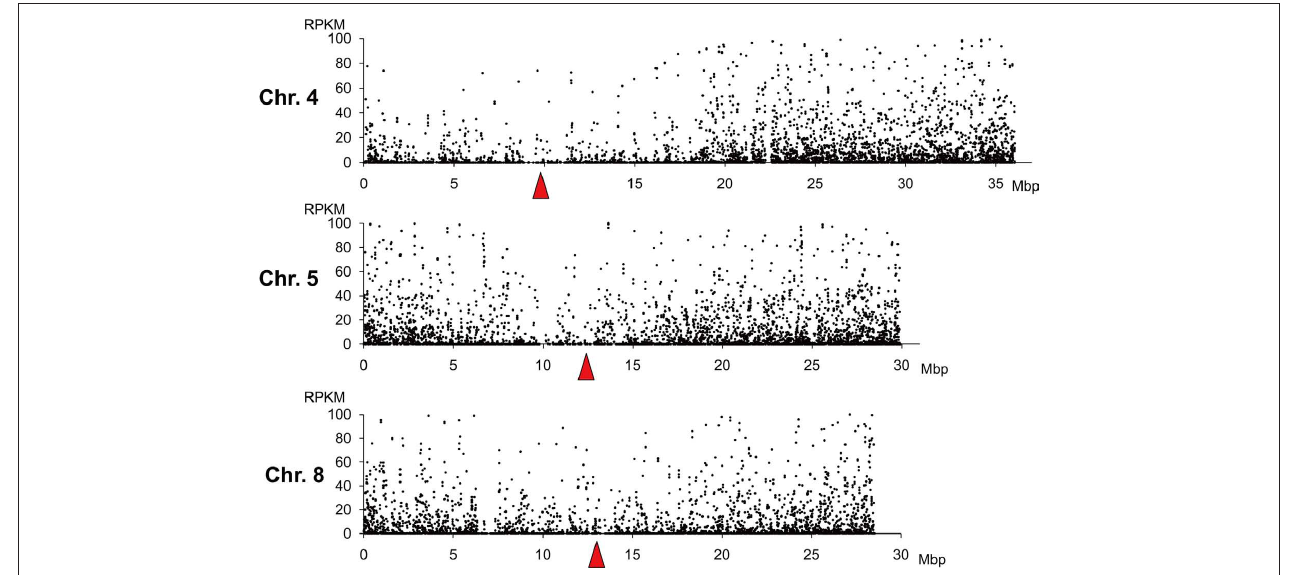
FIGuRe 4 | Relationships between location and RPKM (reads per kilobase of exon models per million mapped reads) of genes. RPKM of each gene on chromosomes 4, 5, and 8 are shown. Only genes with RPKM < 100 are shown. Horizontal axis indicates the positions of genes in the reference rice genome (Build 5.0 pseudomolecules) constructed by the International Rice Genome Sequencing Project. Red triangles indicate the positions of RCS2/CentO